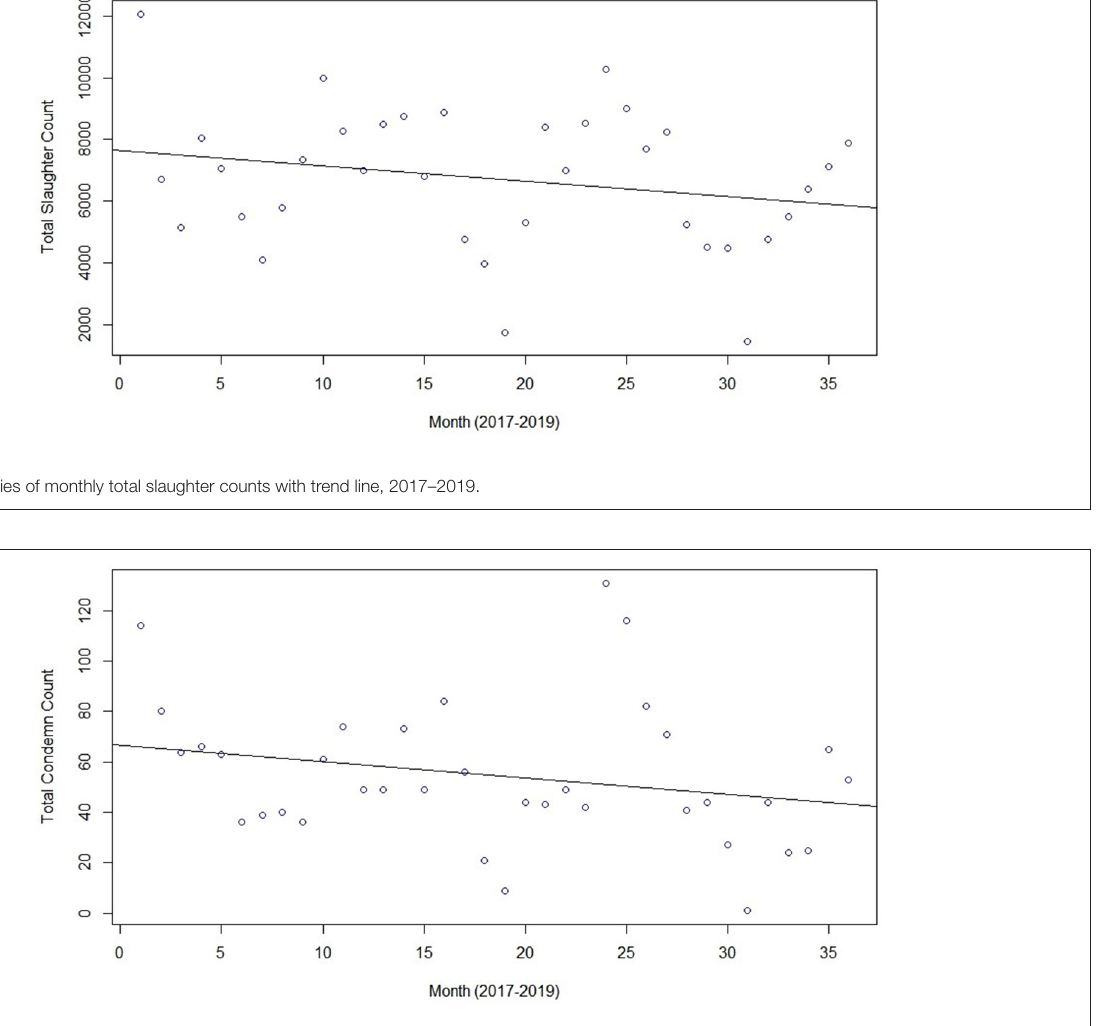
FIGURE 4 | Time series of monthly total condemnation counts with trend line,